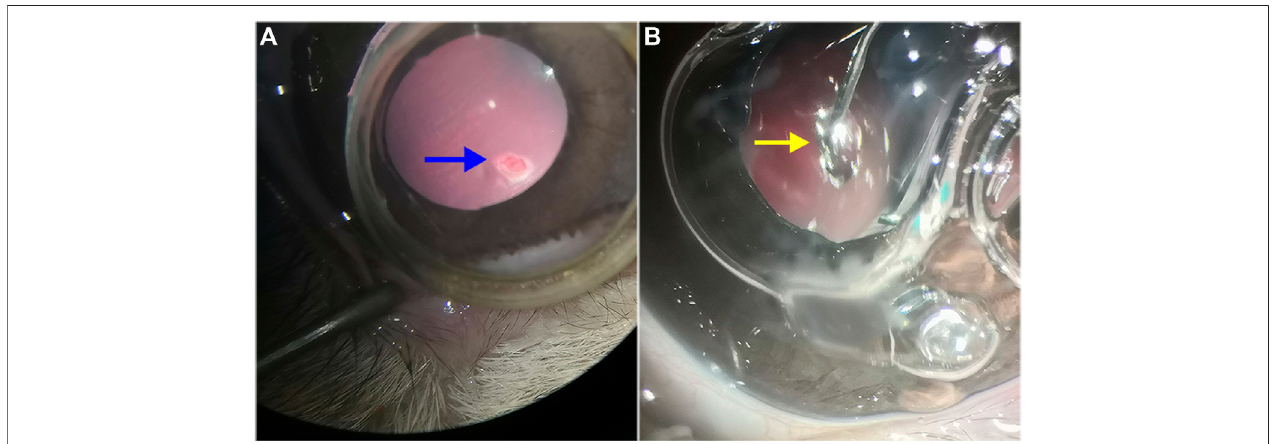
FIGURE 3 | Retinal detachment and HA-engineered hydrogel coverage. (A) After vitrectomy and PVD in the rabbit eye, the vitreous cutter was used to make a retinalbreak that wasapproximately 1/2 DDin size(blue arrow). The break wasmade 2 DDinferior to theopticdisc. (B) TheHA-engineered hydrogel (yellow arrow) was gently applied over the retinal break with a 25-gauge syringe through a trocar cannula in the RRD-hydrogel